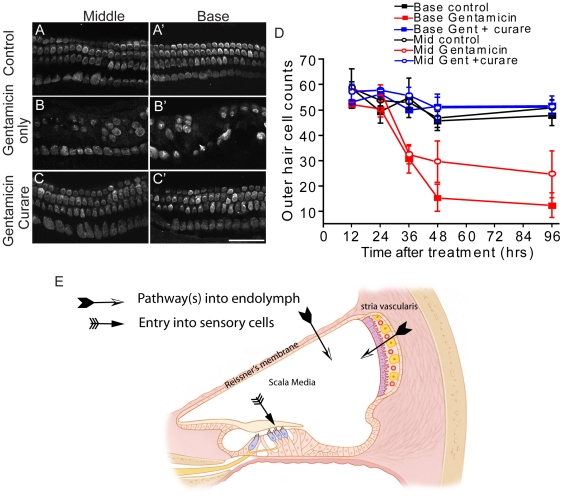
Curare protected hair cells in long-term cultures.A–C. Cochleae treated with gentamicin (0.1 mM) with or without curare (1.0 mM) remained in gentamicin-free media for four additional days. Survival of outer hair cells (determined by parvalbumin 3 labeling) in the curare-treated cochleae was comparable to that in untreated, cultured cochleae. D. Quantitative analysis of the gentamicin-treated cochleae demonstrated a slight decline in outer hair cell survival 96 hr versus 48 hr after treatment. Cochleae co-treated with curare and gentamicin have comparable numbers of outer hair cells at both time points. Each data point represents an analysis of three to twenty-two experiments. E. Schematic of possible entry pathways for aminoglycoside first into the scala media from the stria vasculars or Reissner's membrane, then into sensory hair cells in the inner ear. Error bars = S.D. Scale bar = 50 µm.